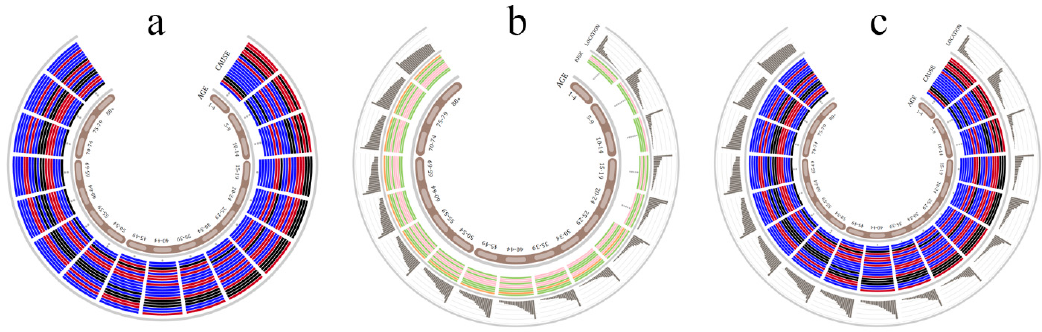
Figure 6. ( a ) Collapsed location and risk tracks; ( b ) collapsed cause track; ( c ) collapsed risk track.